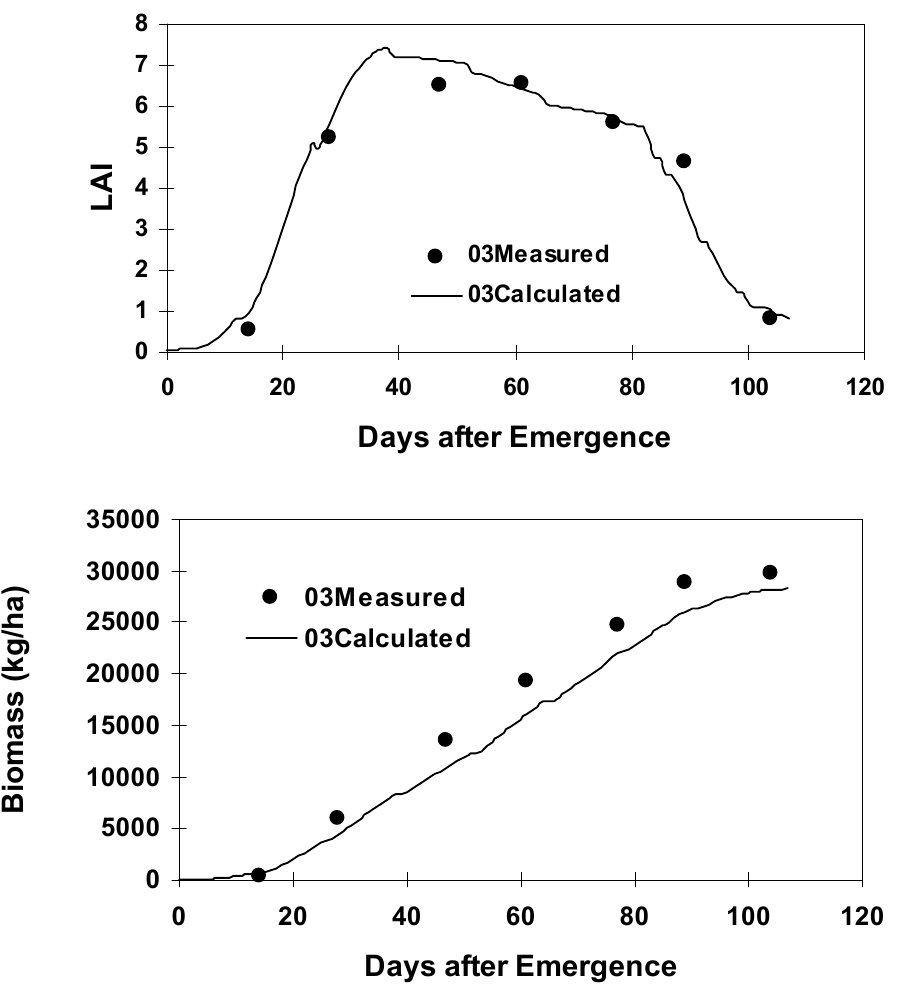
Figure 7. Comparison of calculated and measured leaf area index (LAI), and biomass of